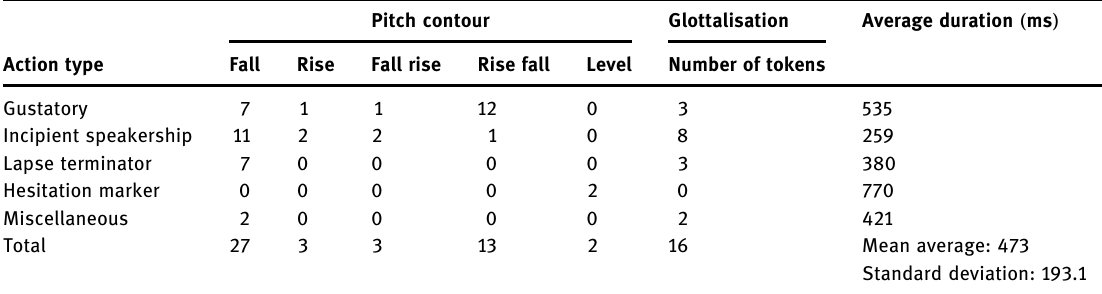
Table 4: Pitch contour, glottalisation, and average duration for action - type classi fi cation for “ mm ” as a response